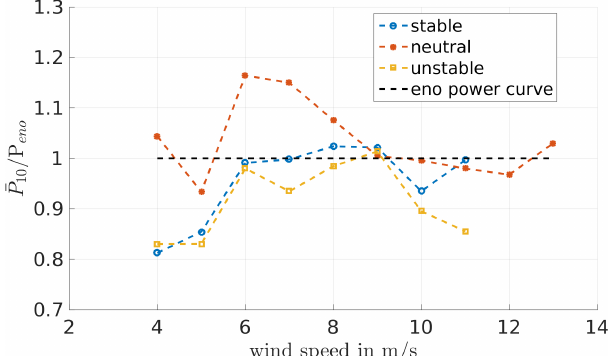
Figure 6. Roughness length distribution for varying wind directions for the measurement period. Two methods of averaging the rough- ness length values gained by Eq. (2) were used; here z 0 denotes the roughness length determined from 30min eddy-covariance data, and j denotes the 15 ◦ wind direction bins: (1) averaging z 0 ,j per 15 ◦ bins (blue) and (2) averaging using ln z 0 ,j = 15 ◦ bins (red), where the angle brackets (cid:104) ... (cid:105) denote the average over values within the 15 ◦ bins.